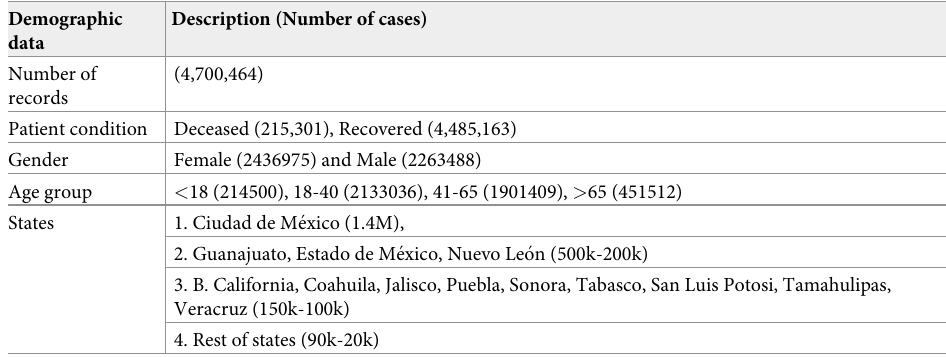
Table 1. Demographic characteristics of COVID-19 patients recorded in the database from the Mexican Federal Government, with a cutoff date of January 31, 2021. Demographic